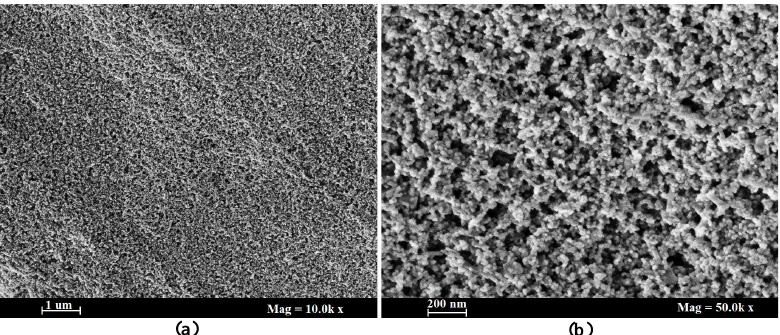
Figure 3. SEM images of as synthesized TiO 2 NPs ( a ) at magnification 10.0 k × and ( b ) at magnifica- tion 50.0 k ×